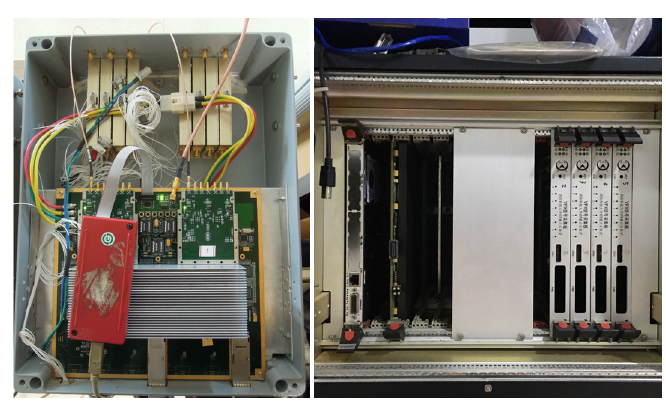
Figure 3. High performance sampling module and signal processing